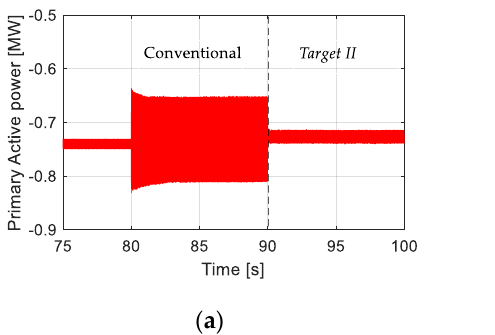
Figure 10. Simulation results comparison with Target II for primary active power ripple elimination. ( a ) Primary active power response; ( b ) Active power components.